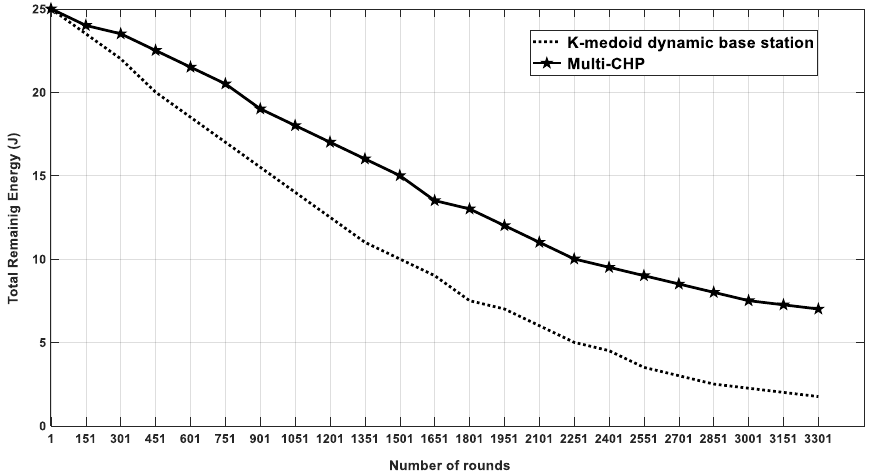
Figure 19. The average residual energy as a function of the simulation rounds for multi-CHP and k-medoid with dynamic base station positioning.